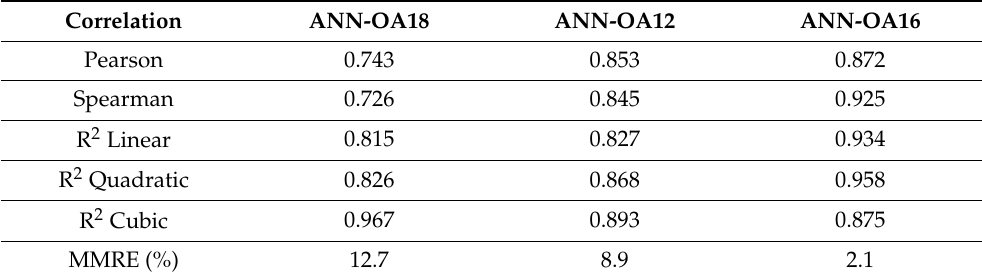
Table 1. Correlation coefficients—Pearson and Spearman—and R 2 values using different kernel functions.